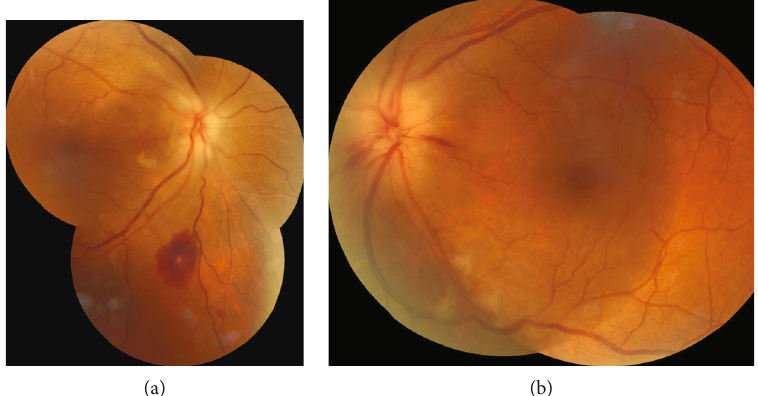
Figure 1: Fundus photography of the right (a) and left (b) eyes showing pale, edematous optic discs, cotton wool patches, and intraretinal hemorrhages.